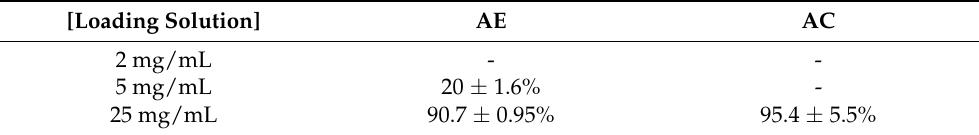
Table 1. Adsorption efficiency and capacity (mean ± standard deviation) from five replicates for each condition on 100 mg of nanoCaCO 3 mixing at RT o.n. in water/ethanol solutions (ratio